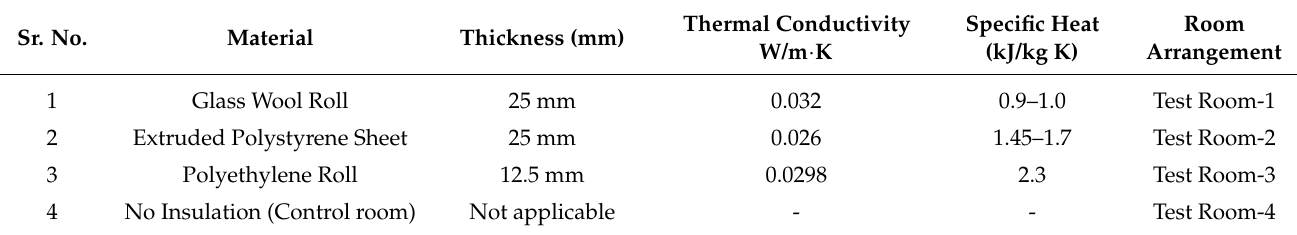
Table 2. Type and details of insulation